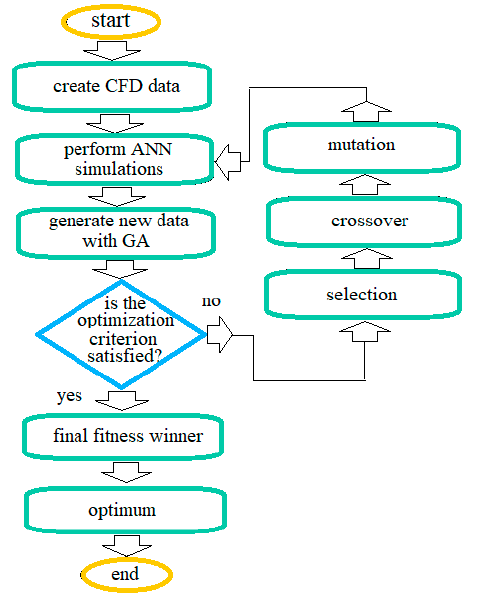
Figure 5. Search process for the optimum when ANN and GA are coupled.